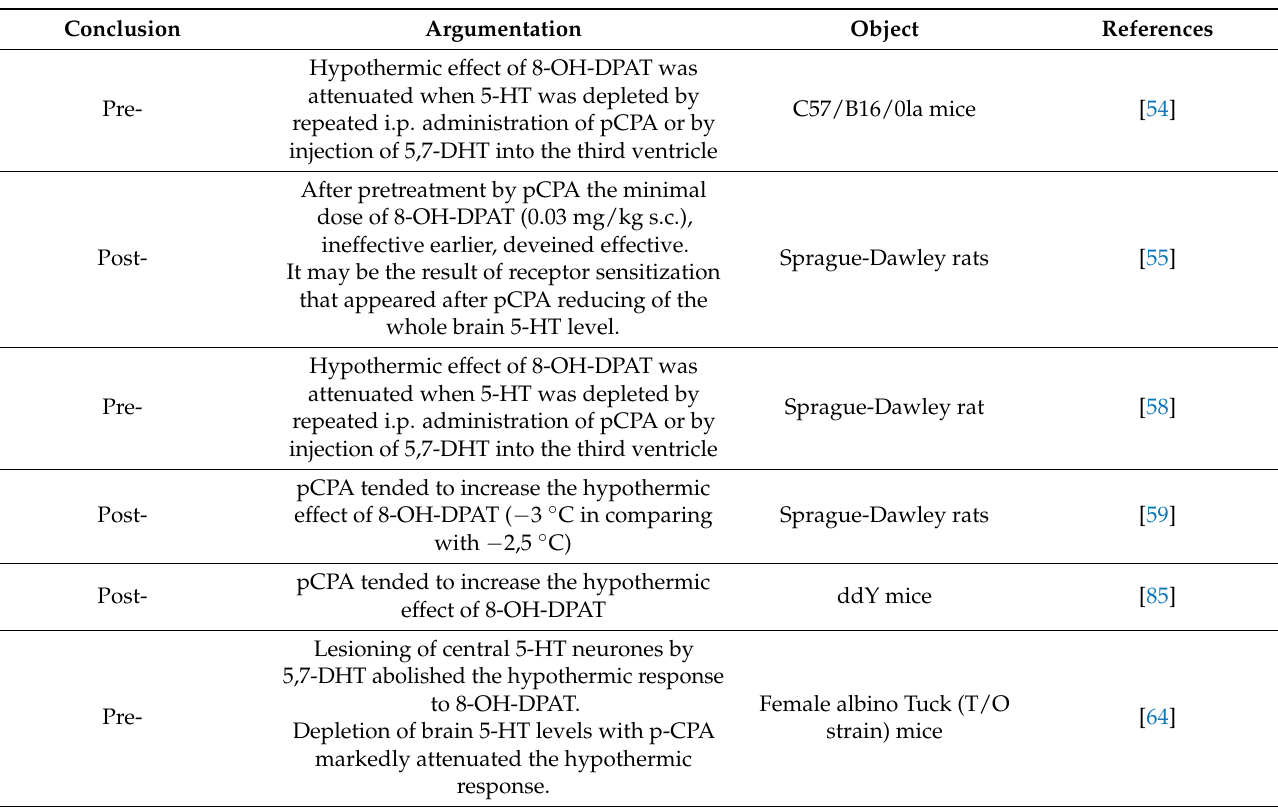
Table 2. Results of investigations of localization of 5-HT 1A receptors mediating the 8-OH-DPAT-induced hypothermia.